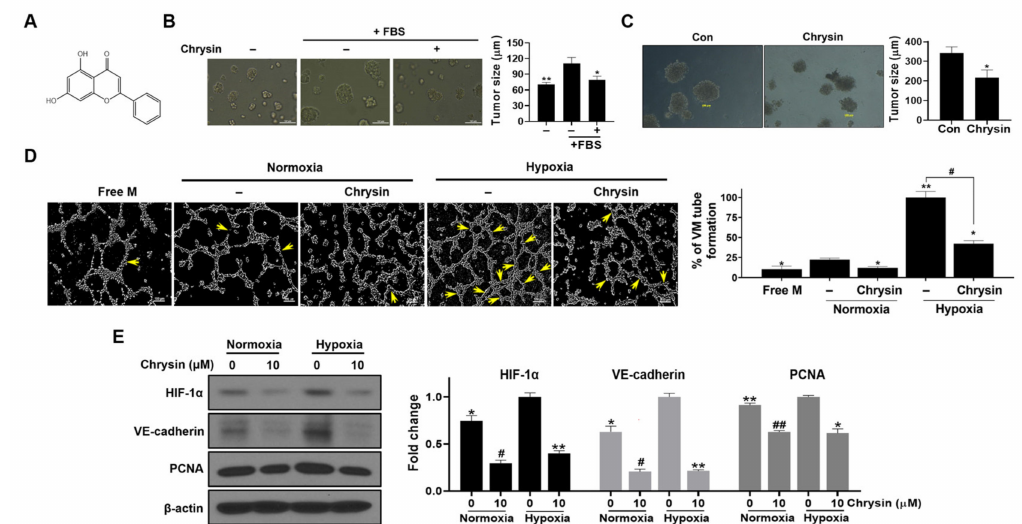
Figure 1. Effect of chrysin on 3D cell growth and vascular mimicry tube formation. ( A ) Chrysin chemical structure. ( B ) PC-3 cells (1 × 10 4 cells/well) were seeded on a 96-well plate coated with Matrigel and treated with chrysin for 48 h. Spheroid formation was photographed at a 20 × field using a microscope (Nikon, Tokyo, Japan). The bar graph indicates tumor size (in µ m) ( n = 3); * p < 0.05 and ** p < 0.01 when compared to the complete medium control group. ( C ) 3D Matrigel embedding culture (i.e., long-term growth). Cells were seeded into an eight-well chamber glass containing the reduced growth factor Matrigel. Cells were maintained for 4 d until spheroid formation, after which PC-3 spheroids were treated with chrysin for 48 h; spheroids were photographed at 40 × field by microscope (Nikon, Tokyo, Japan). The bar graph indicates tumor size (in µ m) ( n = 3) and * p < 0.05 when compared to the untreated control group. ( D ) VM tube formation: PC-3 (3 × 10 5 ) cells were seeded on coated wells in 10% FBS media or serum-free medium (Free M) and incubated at 37 ◦ C under hypoxic or normoxic conditions for 11 h. The formed tubular network indicates a yellow arrow. Bar graph indicates percentage of VM tube formation (%). * p < 0.05 and ** p < 0.01 compared to normoxia control group. # p < 0.05 compared to hypoxia control. ( E ) Representative Western blot images and relative densitometric bar graphs of HIF-1 α , VE-cadherin, and PCNA. The PC-3 cells were treated with chrysin or without for 24 h under normoxic or hypoxic conditions. Cell lysates were used for Western blotting to determine the expression of HIF-1 α , VE-cadherin, PCNA, and β -actin. Data presented as the control’s fold change; * p < 0.05 and ** p < 0.01 when compared to the hypoxia control, while # p < 0.05 and ## p < 0.01 are values when compared to the normoxia